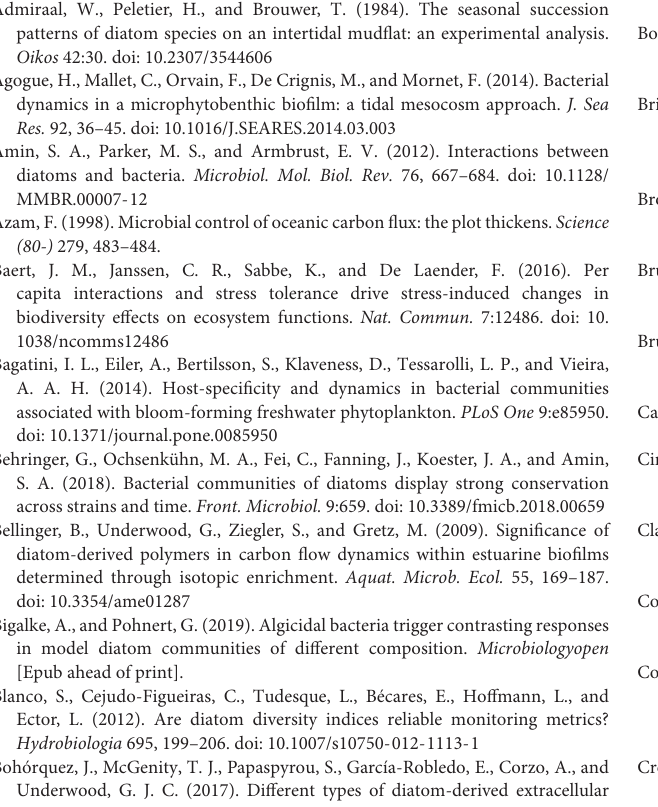
FIGURE S2 | Rarefaction curve for every sample (before removal of rare OTUs) is shown. Colors indicate the different treatments as displayed. FIGURE S3 | The presence of bacteria causes a shift in the relative proportions of diatoms. The relative proportion of C. closterium (red) , S. robusta (yellow) , and N. phyllepta (blue) grown in pairs or altogether expressed as the number of cells per species to the total number of cells in the well (Left = T 1 , Center = T 4 in axenic conditions, and Right = T 4 in non-axenic conditions). Briefly, in axenic conditions an increase in the proportion of C. closterium is observed when grown in the presence of S. robusta , while this observation was not observed in the presence of bacteria. Instead, S. robusta had an increased overall proportion in comparison to C. closterium . FIGURE S4 | The change in the total biovolume ( µ mł) for each of the three diatom species [ C. closterium (red), N. phyllepta (blue), and S. robusta (yellow)] 1 day after inoculation (green area) and 4 days after inoculation (purple area). The gray line indicates the biovolumes under non-axenic conditions while the black line specifies those under axenic conditions. FIGURE S5 | PAM measurements depicting the total fluorescence as a proxy for the total maximum growth rates for different combinations of C. closterium ([C], red), N. phyllepta ([N], blue), and S. robusta ([S], yellow) in the presence (non-axenic) or absence of bacteria (axenic). Combinations of multiple diatoms species together have the appropriate colors combined. The white, gray and dark gray background, respectively show diatoms grown in monocultures, diatom pairs or the three diatom-species combined. FIGURE S6 | PCA on the relative abundance of the bacterial community from the original inoculum (black circle) and when grown in the presence of different